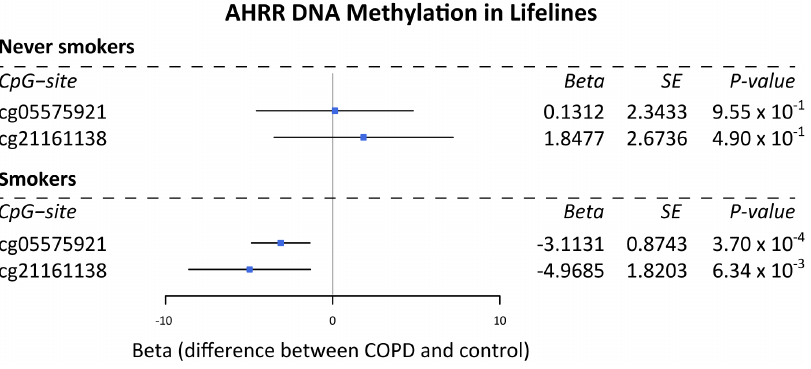
Figure 1. Association of AHRR DNA methylation with COPD in never smokers and smokers from Lifelines. Forest plot of the association between COPD (defined as FEV1/FVC < 70%) and DNA methylation at CpG-sites cg05575921 and cg21161138 in the gene AHRR in whole blood from 658 current smokers and 903 never smokers from the Lifelines DNA methylation cohort study. Beta indicates the effect estimate, i.e., the difference between COPD and control subjects. A negative value points towards a negative association.